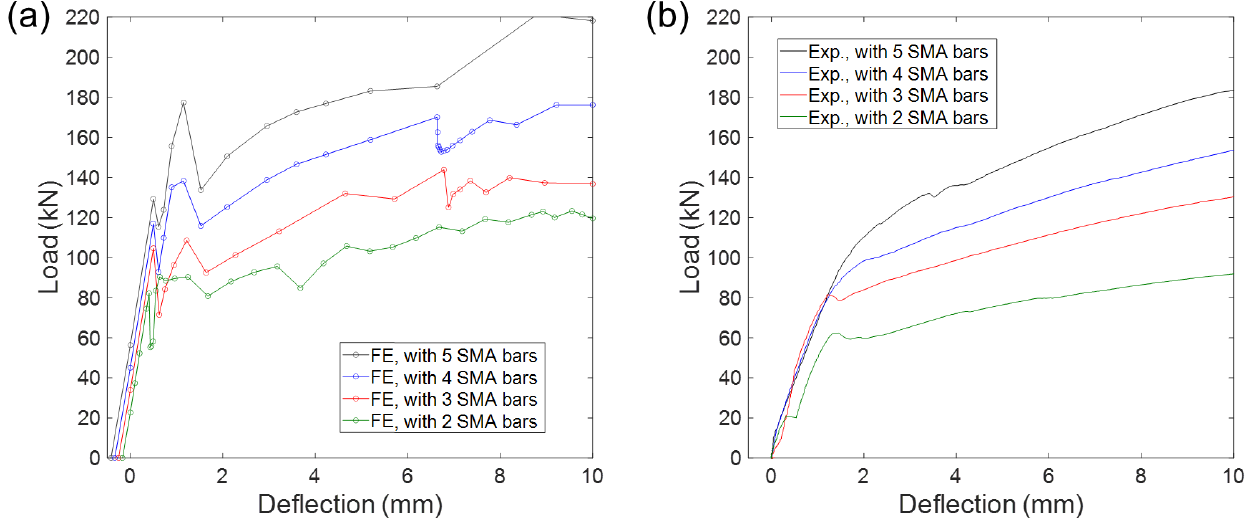
Figure 12. Bending load-deflection curves of RC beams with various numbers of Fe-SMA bars with activation, ( a ) predicted by FE simulations and ( b ) by experiments.